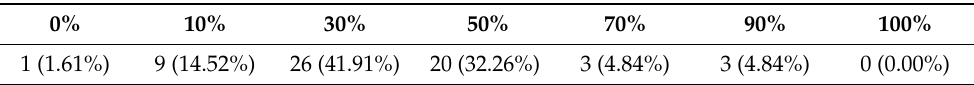
Table 6. Percentages of plagiarized coursework accounting for the total amount of coursework by the perceptions of